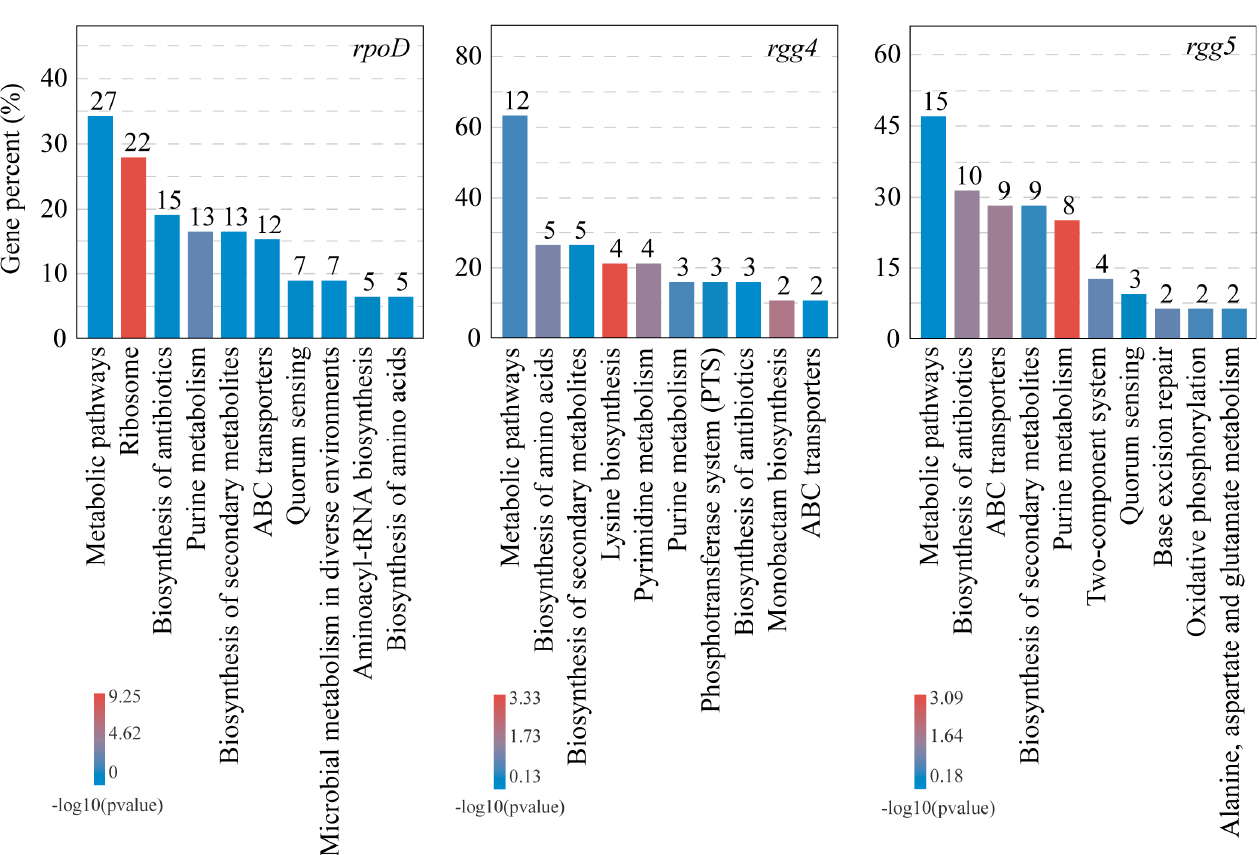
Figure 4. Regulatory pathways of the transcriptional regulators rpoD and rgg in response to high acetic acid stress. The numbers on each histogram indicate the number of genes significantly associated with the transcriptional regulators rpoD or rgg after KEGG enrichment analysis.